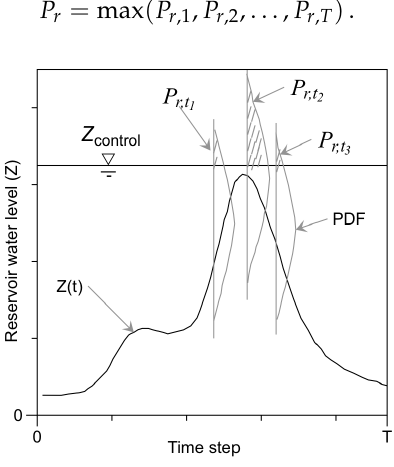
Figure 3. Sketch of the calculation of risk rates during a reservoir flood routing process. PDF: probability density function.